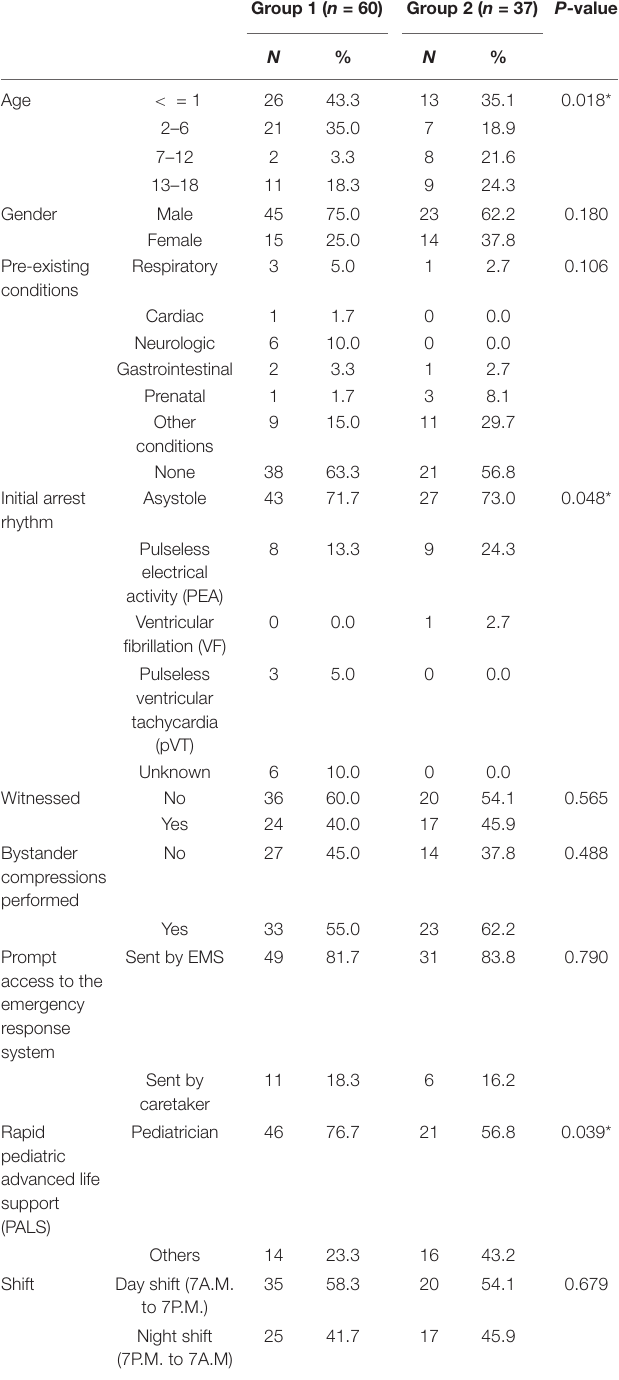
TABLE 1 | Demographics and associations with outcomes of the patients with